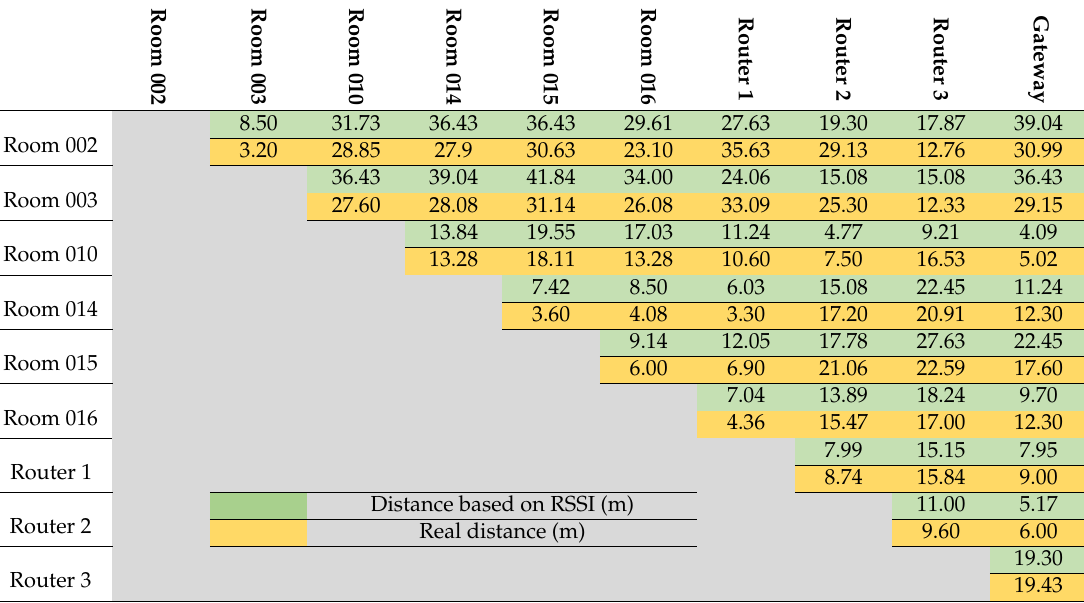
Table 8. Distance based on RSSI versus actual distance in